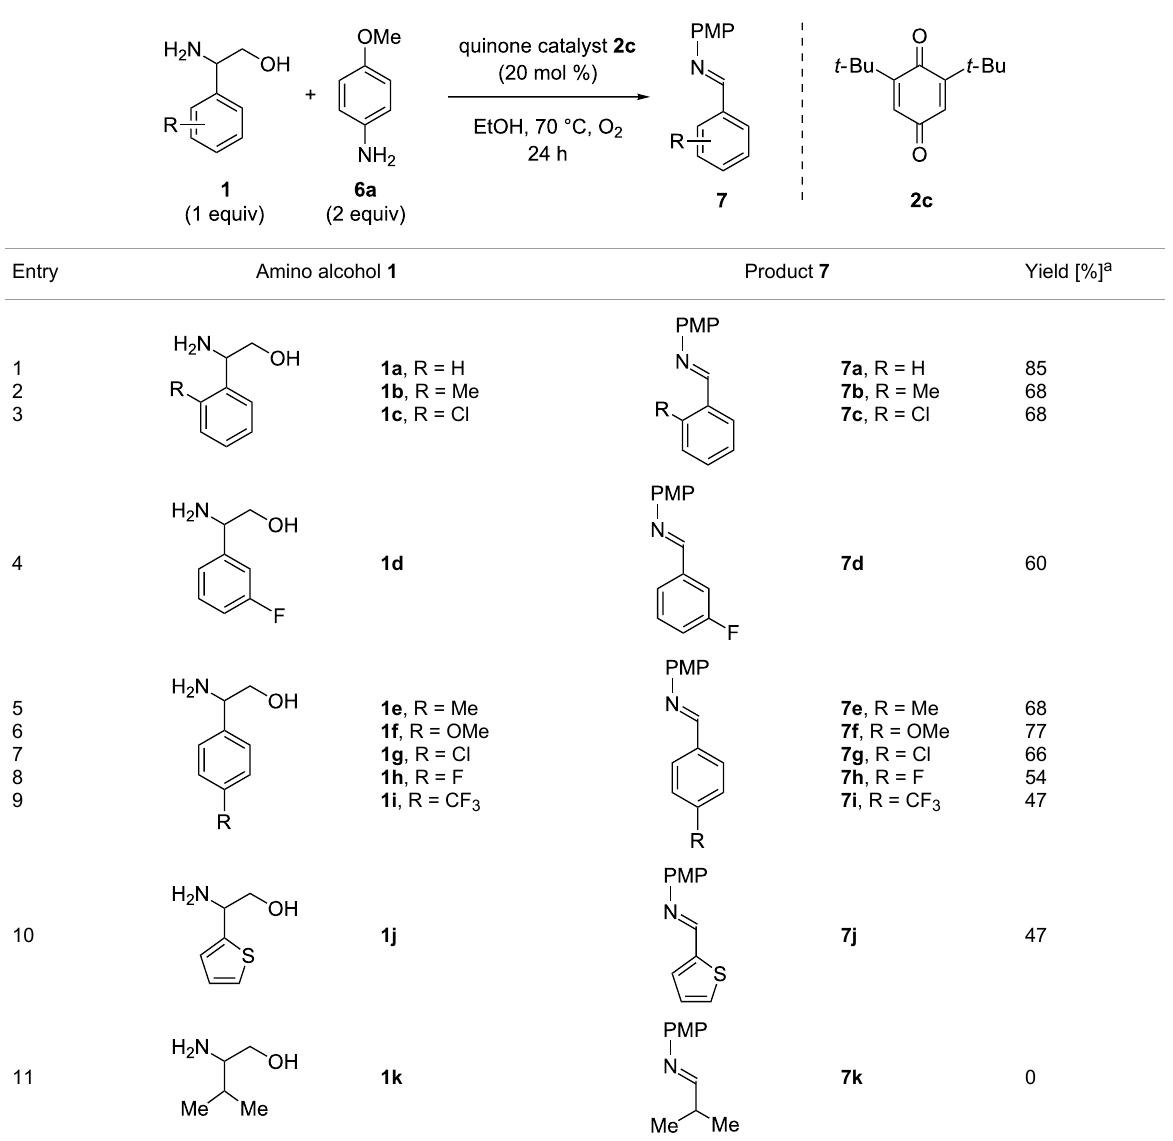
Table 2: Quinone-catalyzed oxidative deformylation of various amino